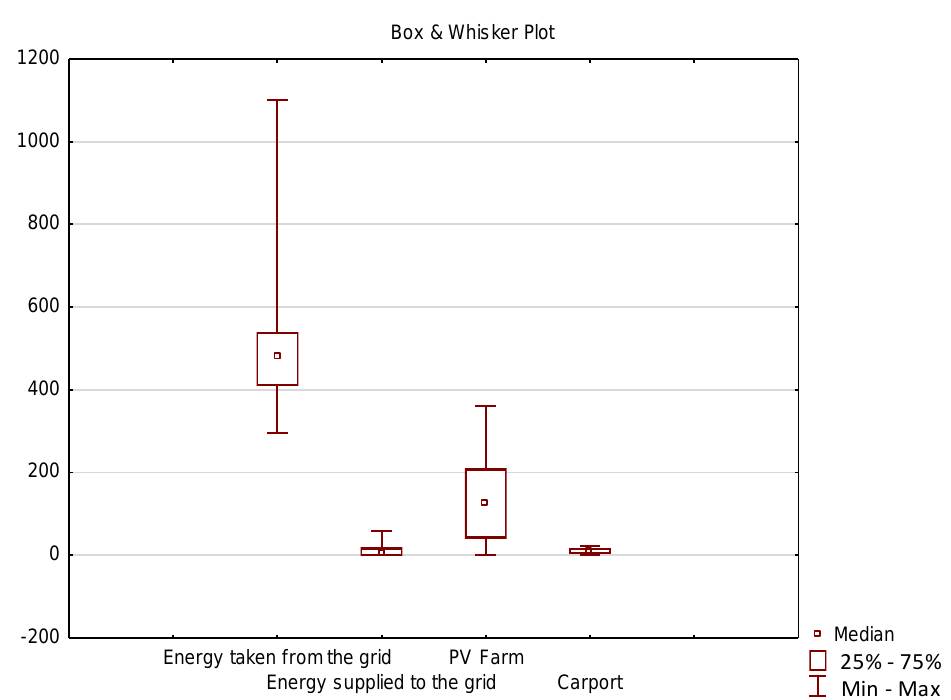
Figure 12. D box plots of analysis parameters of the photovoltaic system.